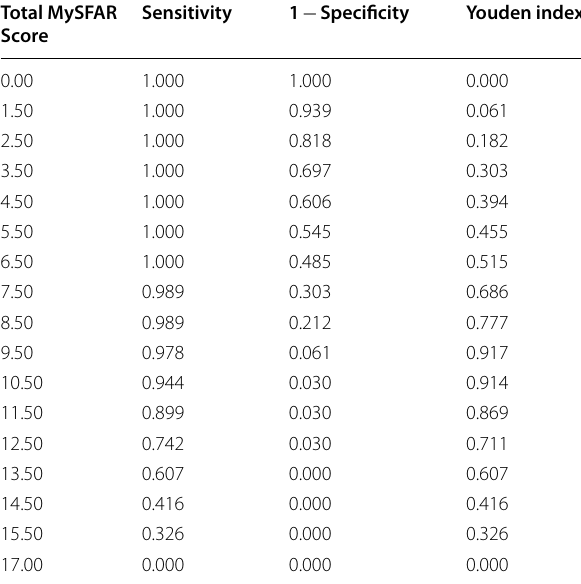
Table 4 Coordinates of curve and Youden’s index Total MySFAR